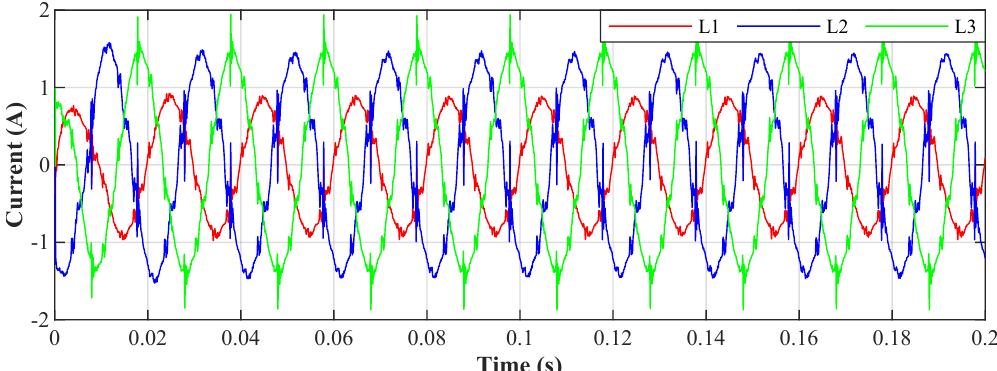
Figure 15. Idle run of test polygon; current waveforms after applying the recursive least squares (RLS) algorithm.